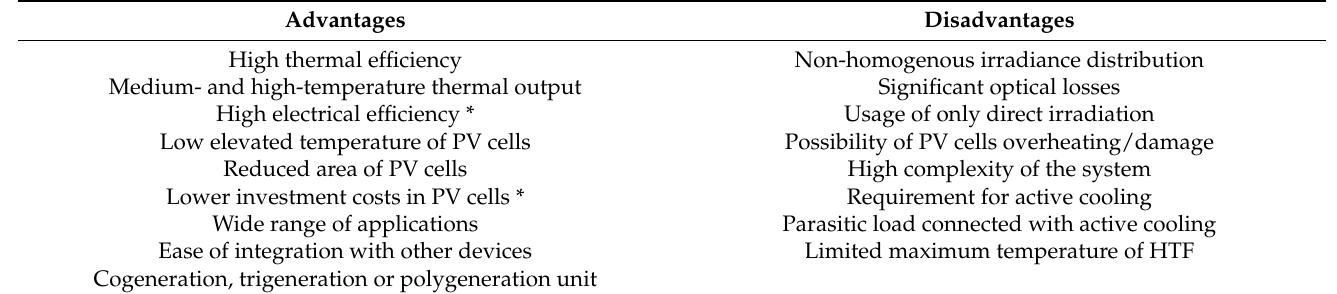
Table 1. Advantages and disadvantages of CPVT systems.